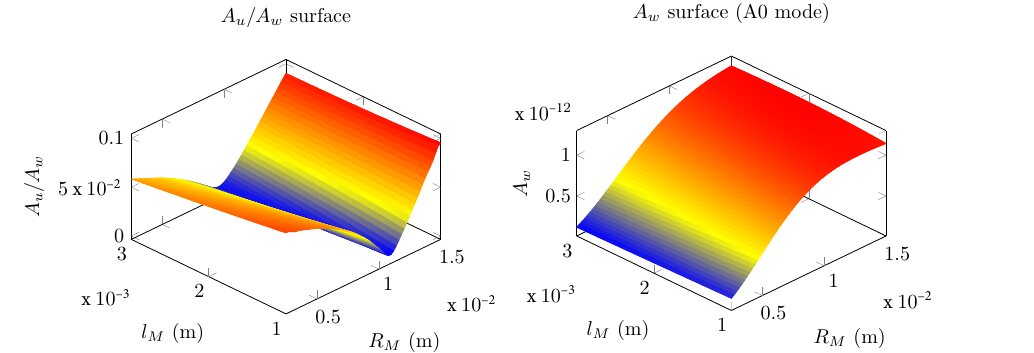
the A0 mode. Using the ratio as the objective function